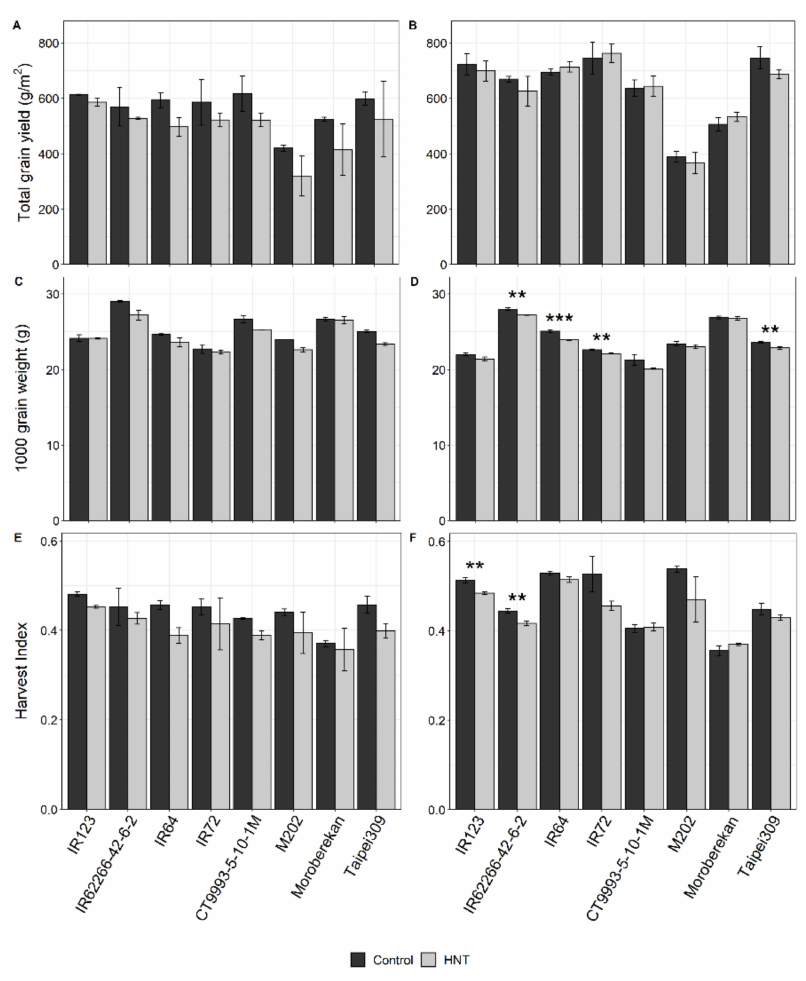
Figure 3. Grain yield ( A , B ), 1000-grain weight ( C , D ) and harvest Index ( E , F ) of eight rice cultivars under control and HNT conditions in the WS ( A , C , E ) and DS ( B , D , F ). For the WS, bars represent the means and error bars, the range of two replicates generated from 12 plants, each. For the DS, the bars represent the means ± SEM of five replicates generated from 12 plants, each. Cultivars are sorted alphabetically within the respective O. sativa subspecies indica (1–4) and japonica (5–8). Significance levels were only calculated for the DS due to an insu ffi cient replicate number in the WS and are indicated by asterisks: 0.001 < ***; 0.001 > ** < 0.01; 0.01 > * <